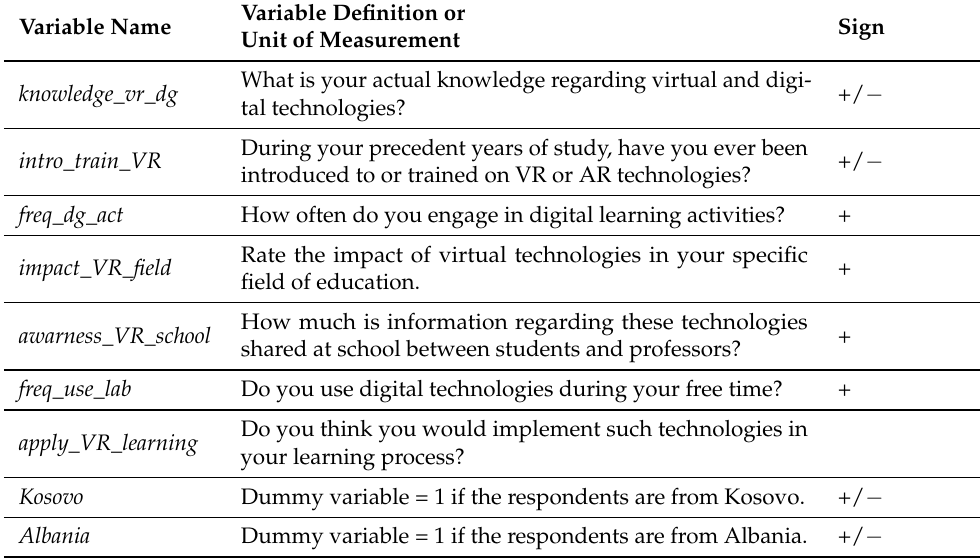
Table 3. Description of the variables employed in the